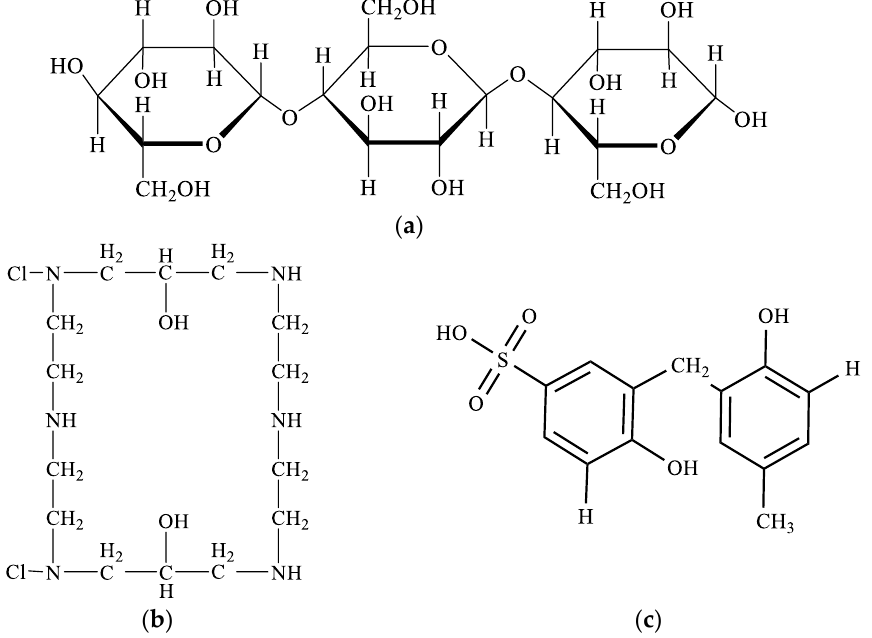
Figure 3. Elemental constituents of the membrane fragments: ( a ) fibrous base, ( b ) anion exchanger, and ( c ) cation